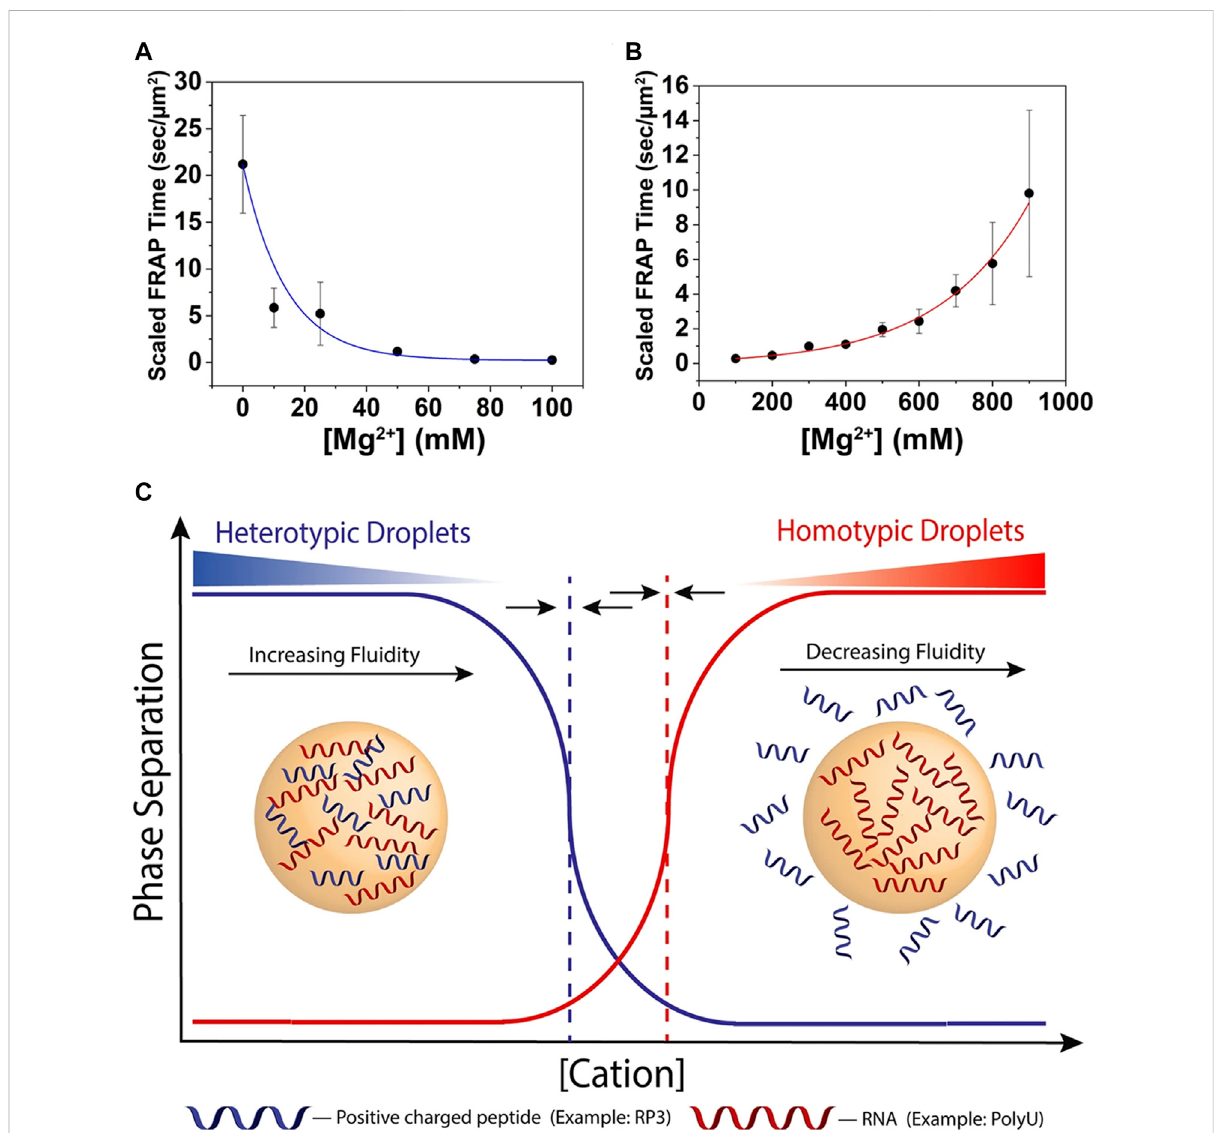
The in fl uence of ion strength. (A) Scaled FRAP in heterotypic RP 3 -polyU droplets as a function of [MgCl 2 ]. ([RP 3 ] = 500 μ M, 0.6x polyU wt/wt) The blue line is avisual guide. (B) Scaled FRAP in homotypic polyU droplets as afunction of[MgCl 2 ].(2 mg/ml polyU, 10%PEG) The red line isa visual guide. (C) Cartoon representation of switch-like behavior between heterotypic and homotypic droplets as a function of increasing cation concentration. The dotted lines represent the phase boundaries of the distinct droplet types. The arrows indicate that these phase boundaries will move under changing conditions and are capable of overlapping (Onuchic et al., 2019). Copyright © 2019 Springer